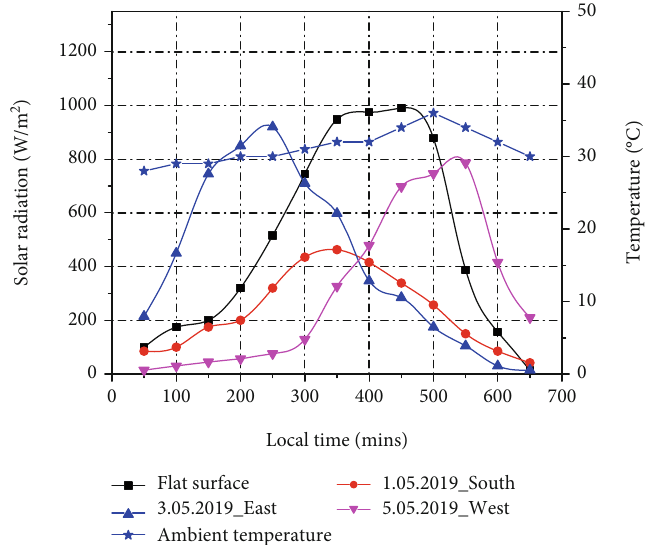
Figure 5: Hourly variation of the incident solar radiation for the various orientations and ambient temperature.